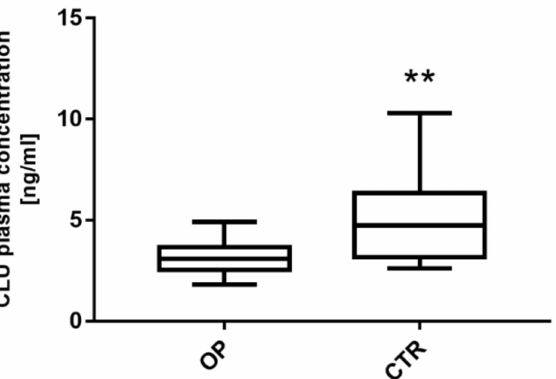
Figure 3. CLU plasma levels in OP patients and CTR subjects. OP patients showed a signifi- cantly lower mean circulating CLU level than CTR subjects (3.15 ± 0.87ng/mL, 4.99 ± 2.07ng/mL) (** p < 0.01).